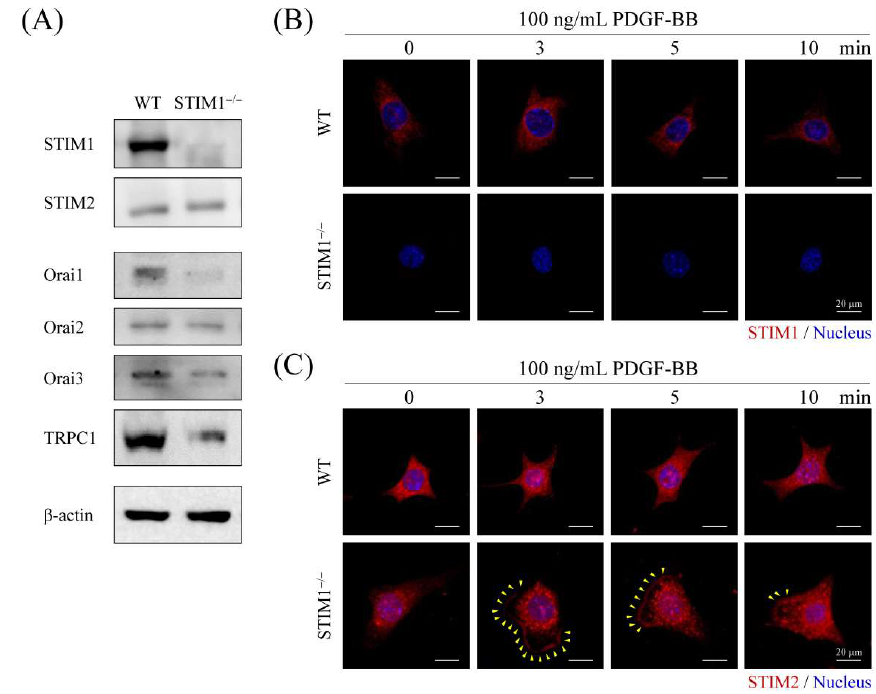
Figure 5. PDGF-BB induces STIM2 puncta formation and translocation in MEF-STIM1 −/− cells. ( A ) STIM1, STIM2, Orai1, Orai2, Orai3 and transient receptor potential canonical 1 (TRPC1) were detected using immunoblotting in both MEF-WT and MEF-STIM1 −/− cells. β-actin served as the internal control; ( B , C ) MEF-WT and MEF-STIM1 −/− cells were starved in a serum-free medium and then stimulated with 100 ng/mL PDGF-BB for 3, 5, and 10 min. Then, cells were processed for immunofluorescence staining using ( B ) anti-STIM1 or ( C ) anti-STIM2 antibody, followed by adding a secondary antibody coupled to Alexa Fluor ® 594 dye and Hoechst 33342 (blue) was used as the nuclear marker. Fluorescence images were captured using a laser scanning confocal microscope. Yellow arrowheads indicate plasma membrane translocation of the STIM2 protein. Scale bars = 20 μm.